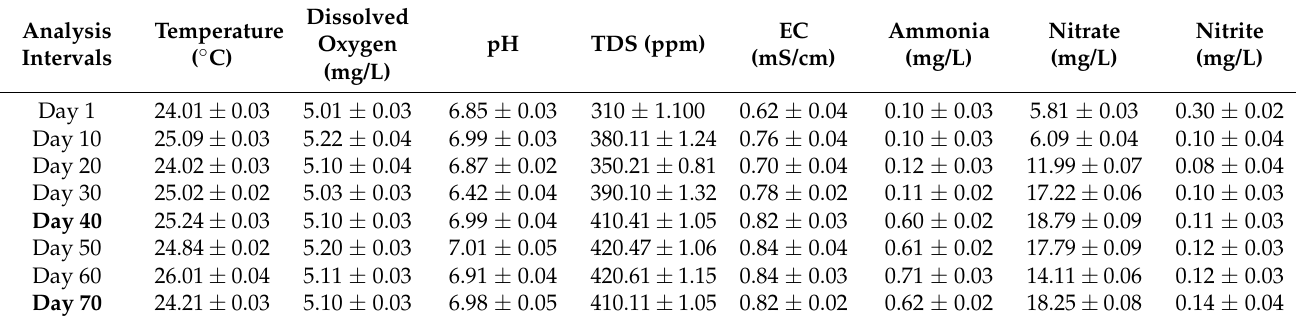
Table 4. The average water parameters under aquaponic system during 10 day